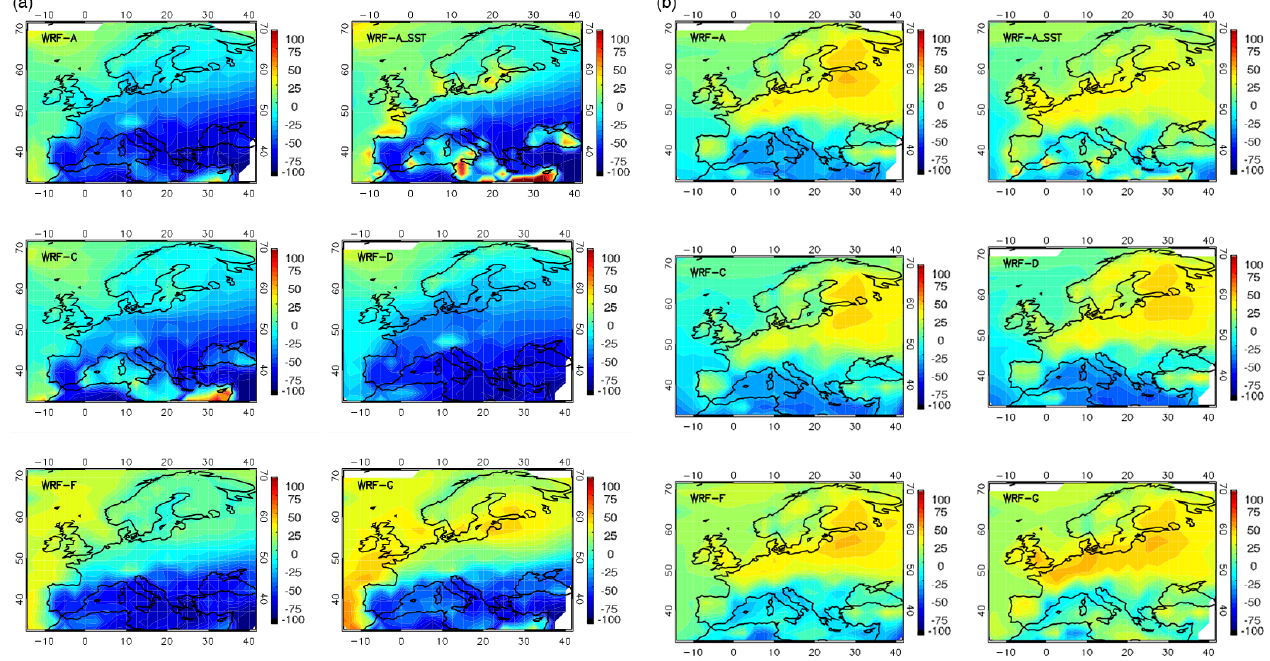
Figure 8. (a) Mean summer and (b) mean winter 1990–2008 total cloud cover bias